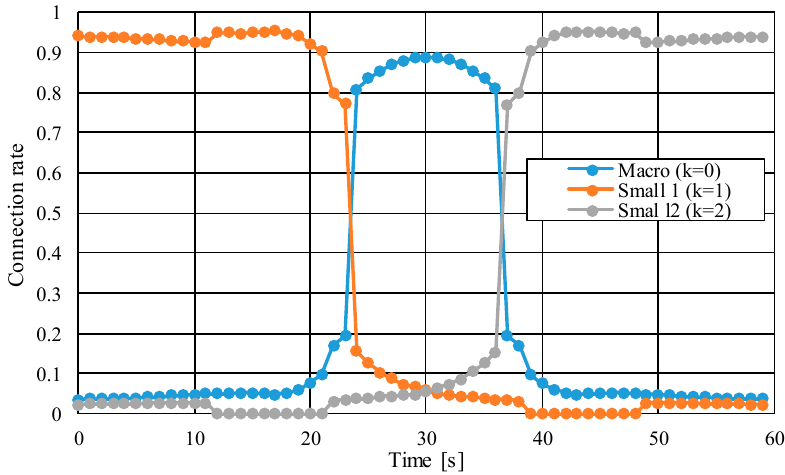
Figure 9. Connection rate of each base station in this scenario.